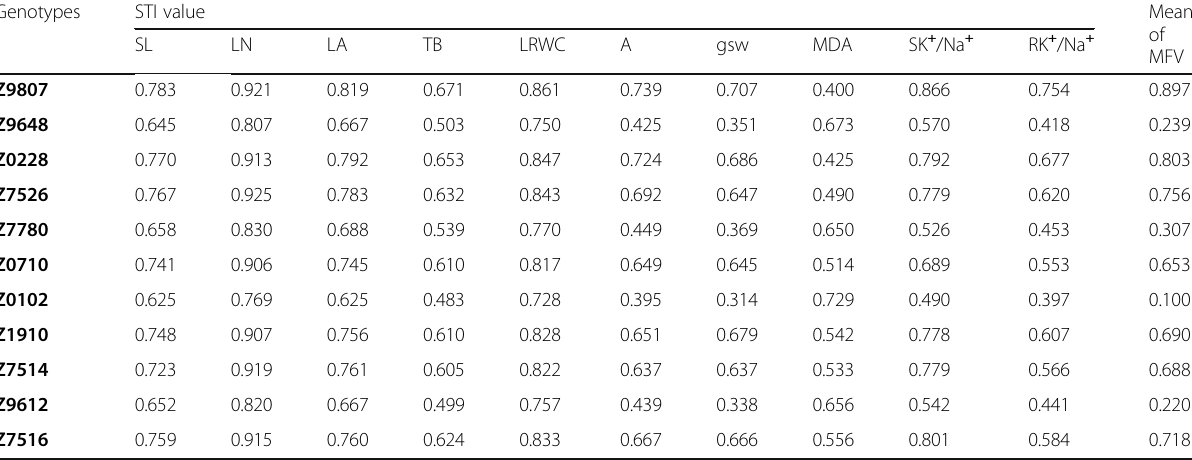
Table 2 Salt tolerance verification with their mean MFVs Genotypes STI